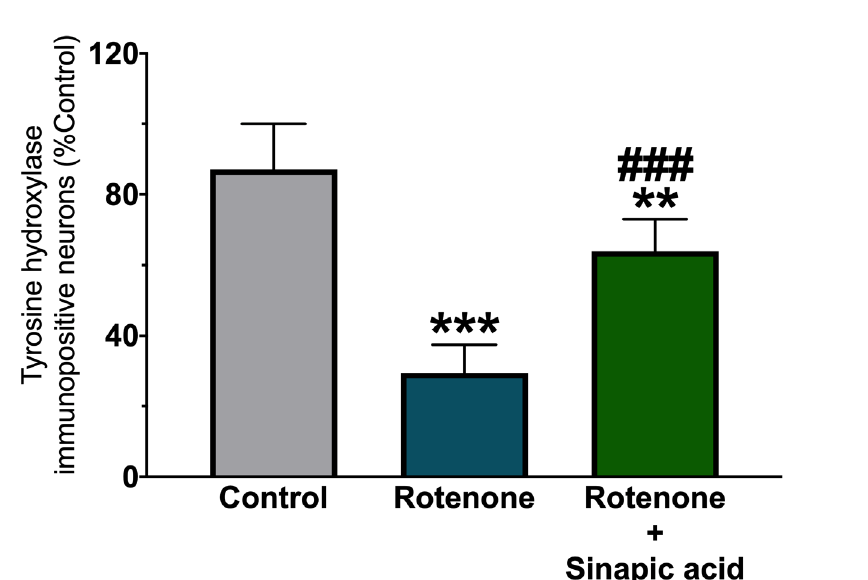
FIGURE 7 - Number of TH immunopositive neurons. Intact side was accepted as control. Rotenone significantly decreased TH (+) neuron percentage. Sinapic acid alleviated rotenone-induced loss of TH (+) neurons. All data expressed as mean ± SD. ***p<0.001, **p<0.01 versus control group, ### p<0.001, versus rotenone